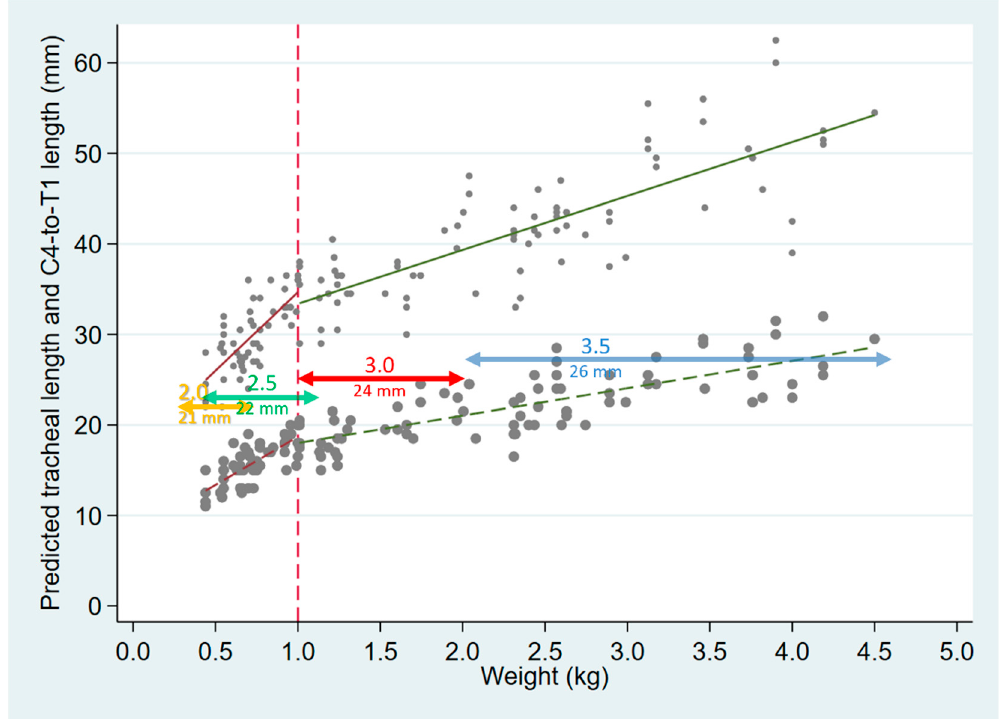
Figure 4. Tracheal length (small gray circles, with solid regression lines as in Figure 3), and C4–T1 length (larger gray circles and corresponding dashed regression lines), both plotted as a function of weight. The horizontal, colored lines are plotted at distances corresponding to the tip-distal glottic depth mark on ETTs sizes 2.0–3.5, with the horizontal span of the lines representing the approximate range of infant weights for whom each ETT size is appropriate.